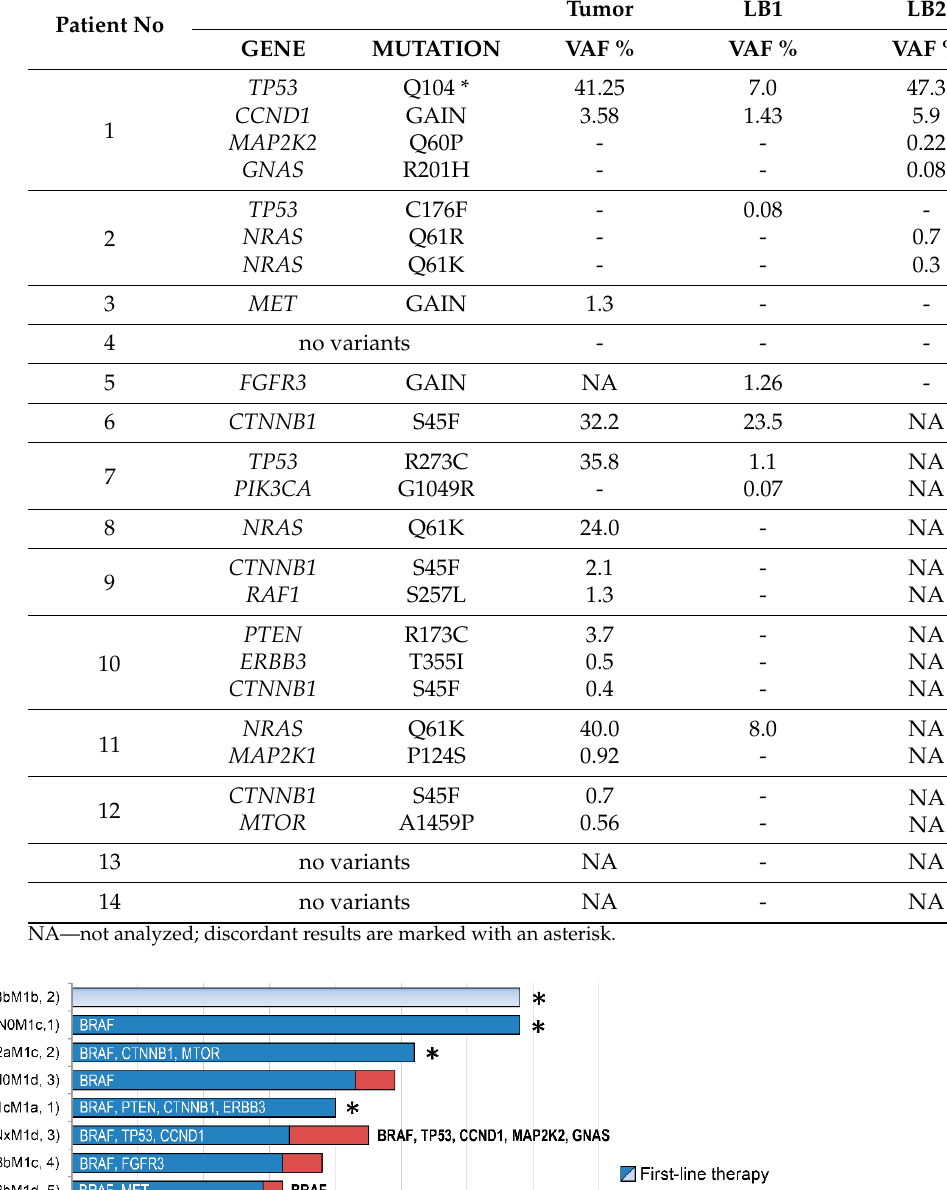
Table 4. Non-BRAF variants detected by targeted NGS in patient samples.